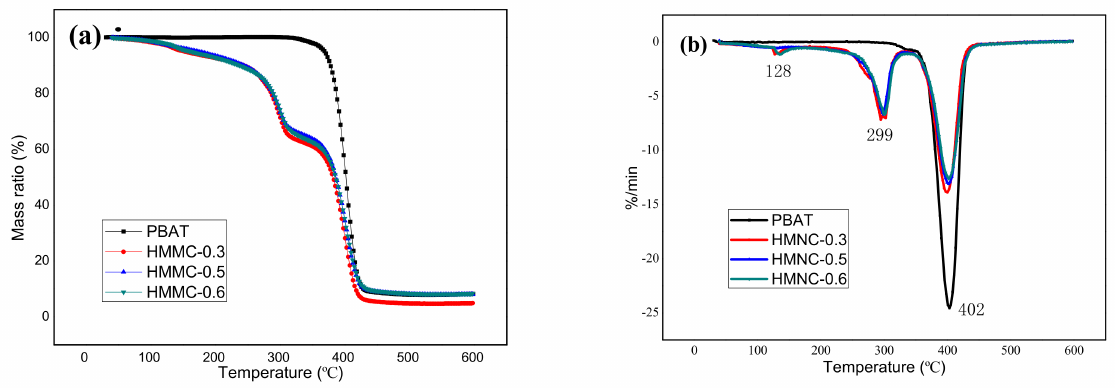
Figure 3. The DG and DTG curves of PBAT-HMNC: ( a ) the TG curves; ( b ) The DTG